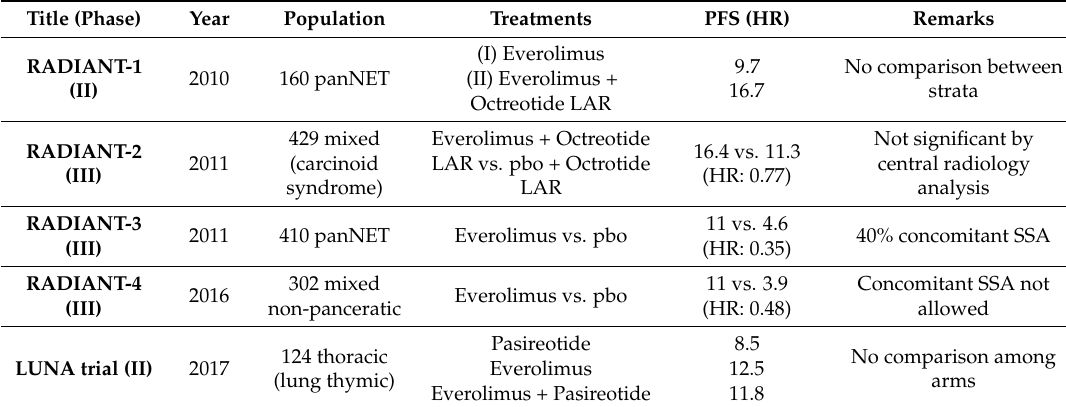
Table 1. Clinical trials on Everolimus in neuroendocrine tumors